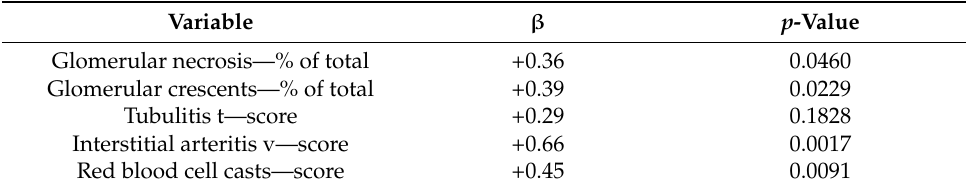
Figure 2. CRP elevation is correlated with complement C4 deposits in interstitial arteries in MPO-ANCA-associated renal vasculitis. Correlations between CRP levels, serum C3 and C4 measurements, and intrarenal complement C3 and C4 deposits localized to different vascular compartments in ANCA-associated renal vasculitis are shown by heatmaps reflecting the mean values of Spearman’s ρ; circle size represents the significance level. Table 2. Multiple linear regression analyses correlating with CRP levels in MPO-ANCA-associated renal vasculitis.